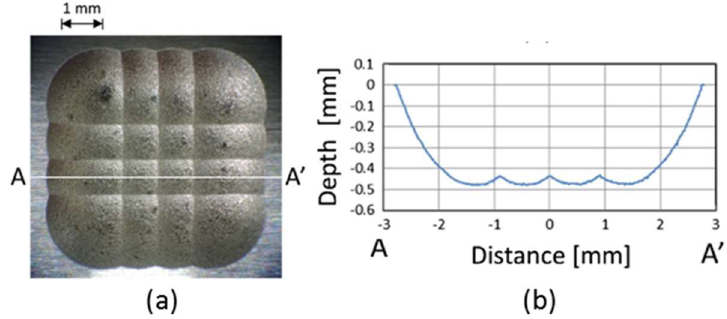
Figure 8. Micro lens array mold insert fabricated by electric discharge machining (EDM). ( a ) Mold surface observed with optical microscope, ( b ) cross section of the surface along line AA’. Reproduced with permission from [92].